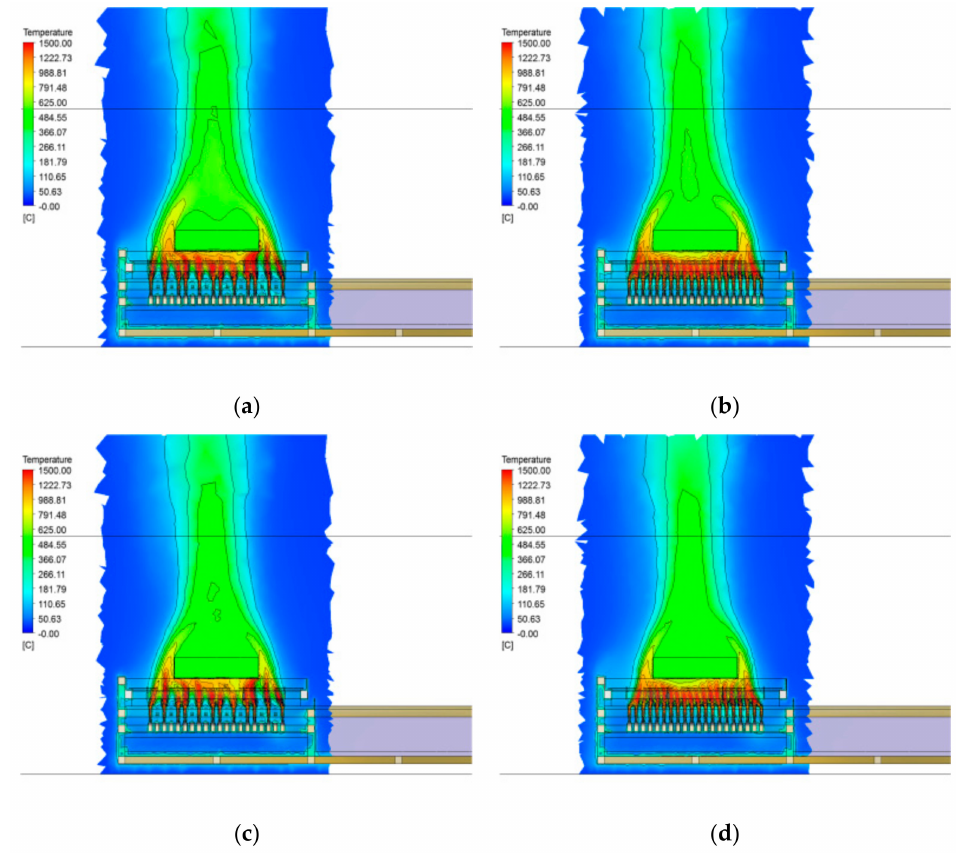
Figure 12. Temperature distribution at central section of mock-up: ( a ) test apparatus (A) with . m LPG = 35 kg / h; ( b ) test apparatus (B) with ( d ) test apparatus (B) with